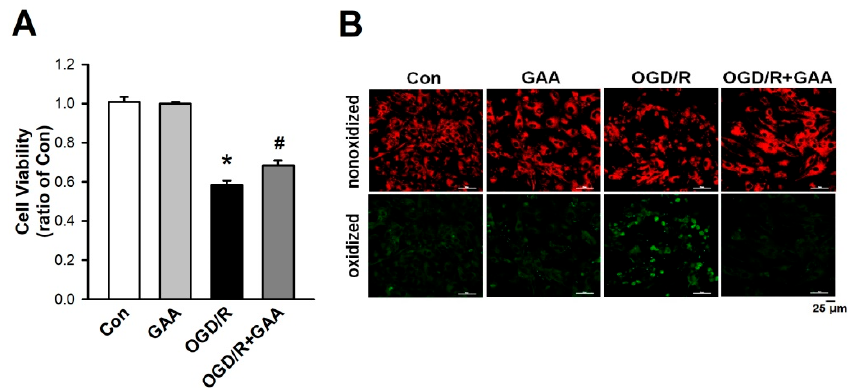
Figure 6. GAA reduces OGD/R -induced cell death and inhibits lipid peroxidation in neonatal rat cardiomyocytes. ( A ) Neonatal rat cardiomyocytes were exposed to OGD/R, and cell survival was determined 24 h after OGD/R using the MTT assay. The results show that OGD/R leads to significant cell viability reduction. This effect was rescued by a posttreatment with 5- μ M GAA (n = 4). The same experimental group was assessed by repeating the cell culture four times. ( B ) Confocal images of neonatal rat cardiomyocytes treated with OGD/R. A significant increase was observed in the level of lipid peroxidation (green), but this effect was abolished by a post-treatment with 5- μ M GAA. Red, nonoxidized form of C11 BODIPY; Green, oxidized form of C11 BODIPY. Scale bars: 25 μ m. All data are represented as the means ± SEM. * p < 0.05 versus the control group; # p < 0.05 versus OGD/R. Con, control; GAA, gossypol acetic acid; OGD/R, oxygen-glucose deprivation/reperfusion.